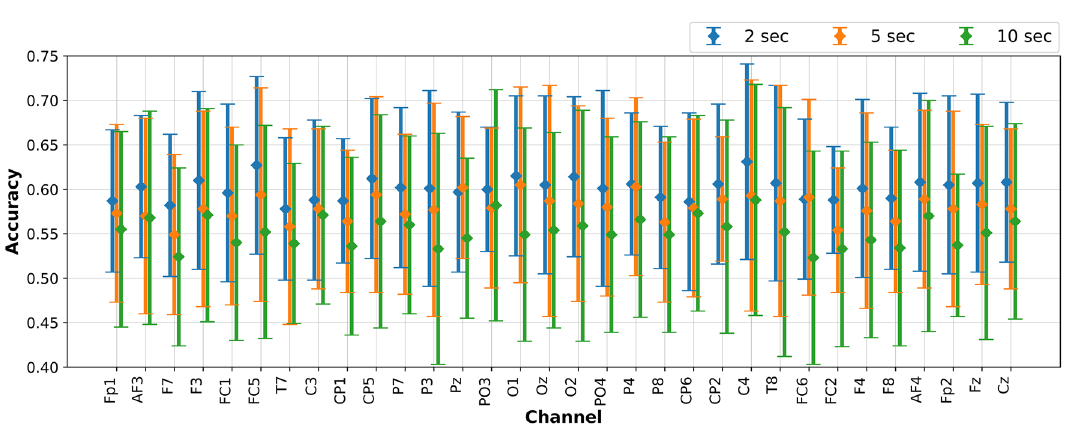
Figure 5. Low vs high valence classification accuracies and standard deviation for the test set (25% of the data) using EEG data from one channel at a time and the